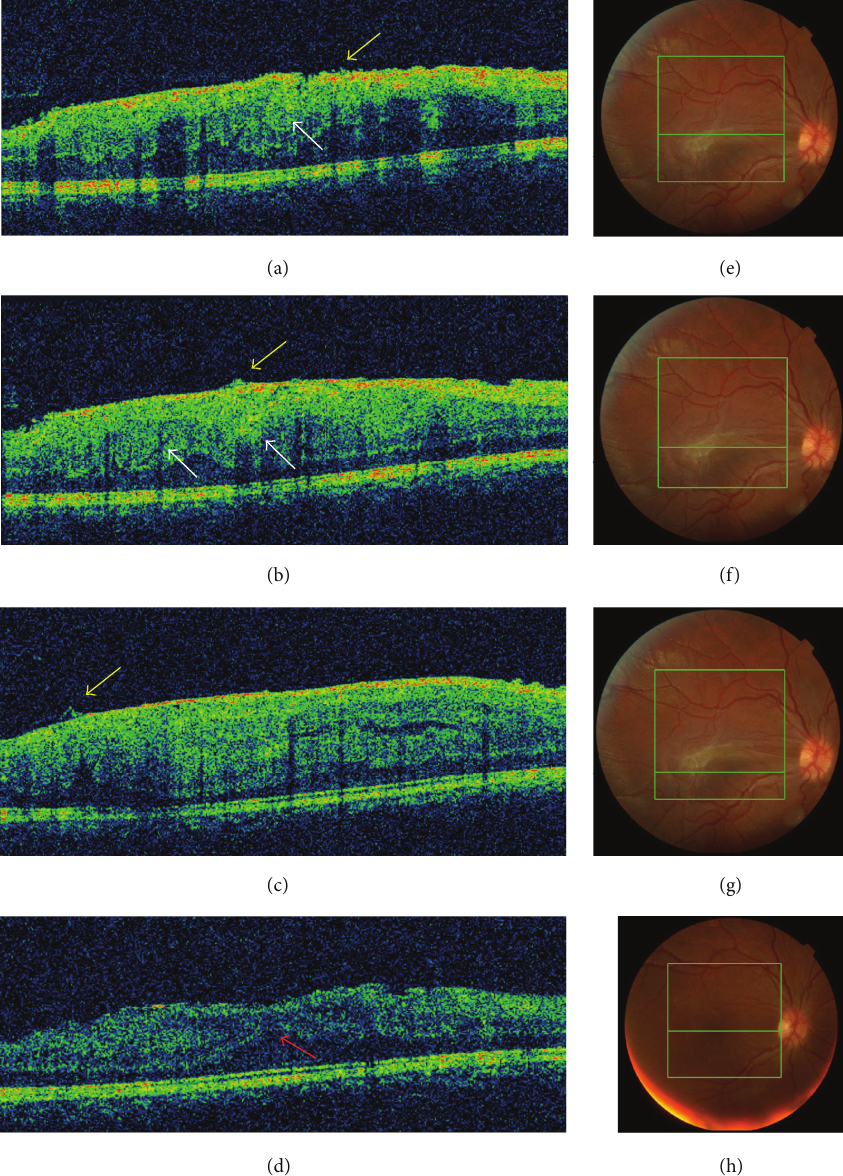
Figure 3: (a, b, and c) OCT at initial presentation and (d) 18 months after follow-up. (e, f, g, and h) Fundus photography corresponding to each OCT. (a, b, and c): The lession reveals disorganization of normal retinal layers, with hyperrfletive surface and hyporreflective shadowing. White arrows: full thickness retinal folds with superficial and deep retinal distortion. Yellow arrows: peaks in the inner retina correspondig to the traction caused by the epiretinal membrane. (d): OCT 18 months after follow-up, showing relief of the macular traction and reduction of macular thickness. Retinal layers can be identified. Red arrow: outer nuclear